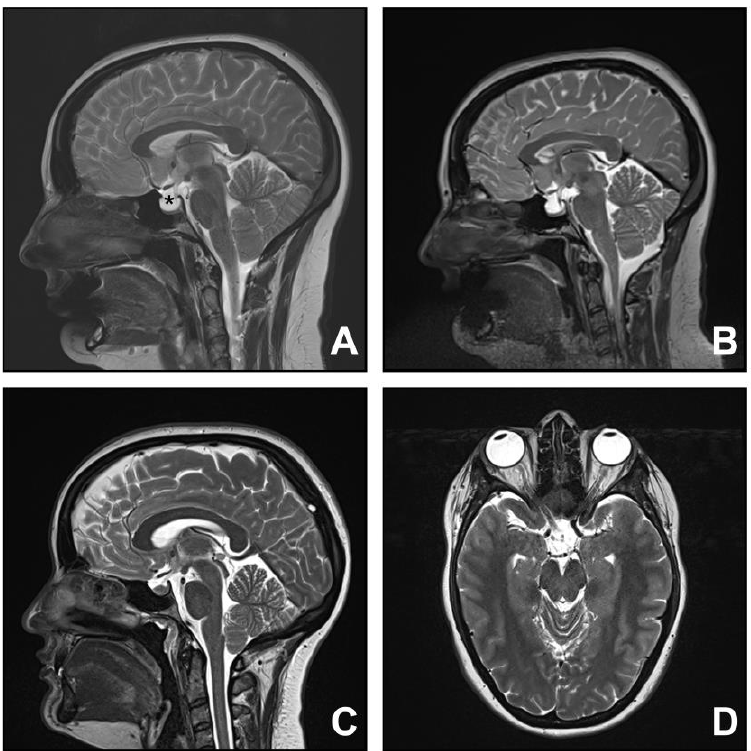
Figure 4. Chiari mimic: idiopathic intracranial hypertension. Two female patients with high body mass indexes (>30) (Case 11. ( A , B ); Case 12. ( C , D )) presented with occipital headaches exacerbated by cough and MRI features suggestive of Chiari I malformation ( A , C ). In addition, there were concomitant imaging features of intracranial hypertension, such as empty sella (( A ); * for empty sellar) and tortuosity and distension of the optic nerves ( D ). There was a persistent empty sella (B) post-posterior fossa decompression.